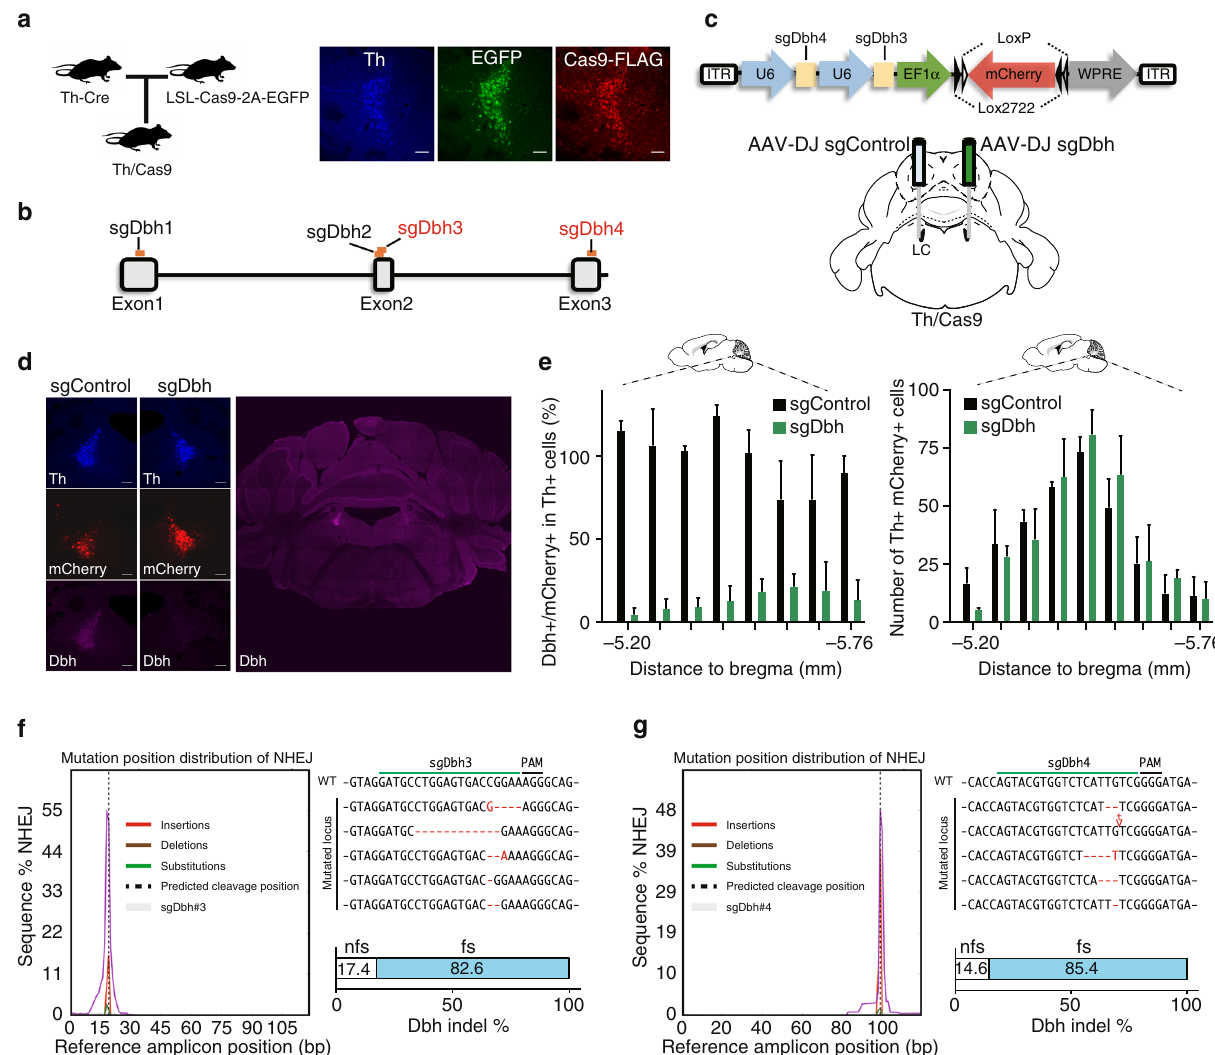
Fig. 1 Cre-dependent gene editing of dbh in the locus coelureus using CRISPR/Cas9. a Design for expressing Cas9 in LC-NE (left). Representative immuno fl uorescence images of Th, EGFP, and Cas9-FLAG in the LC from Th/Cas9 mice (right). b sgRNA design for targeting the mouse dbh locus. c Schematic of the AAV sgDbh vector and experimental design. d Representative immuno fl uorescence images of the LC from Th/Cas9 mice injected with AAV-DJ sgControl (left hemisphere) or AAV-DJ sgDbh (right hemisphere). Scale bar, 100 μ m. e The percentage of Dbh-positive cells in mCherry- and Th- double positive LC neurons from Th/Cas9 mice injected with AAV-DJ sgDbh or sgControl in 40 μ m brain sections from the rostral-to-caudal ends of the LC ( n = 3 mice; anteroposterior, − 5.12 to − 5.76). f , g dbh exon2 ( f ) and exon3 ( g ) mutations analysis of the punch-dissected LC from Th/Cas9 mice injected with AAV-DJ sgDbh. Mutation position distribution of NHEJ (left). Representative mutations (top right). The percentage of frameshift (fs) and non-frameshift (nfs) mutations (bottom right). The LC in c and e was de fi ned as the Allen Reference Atlas